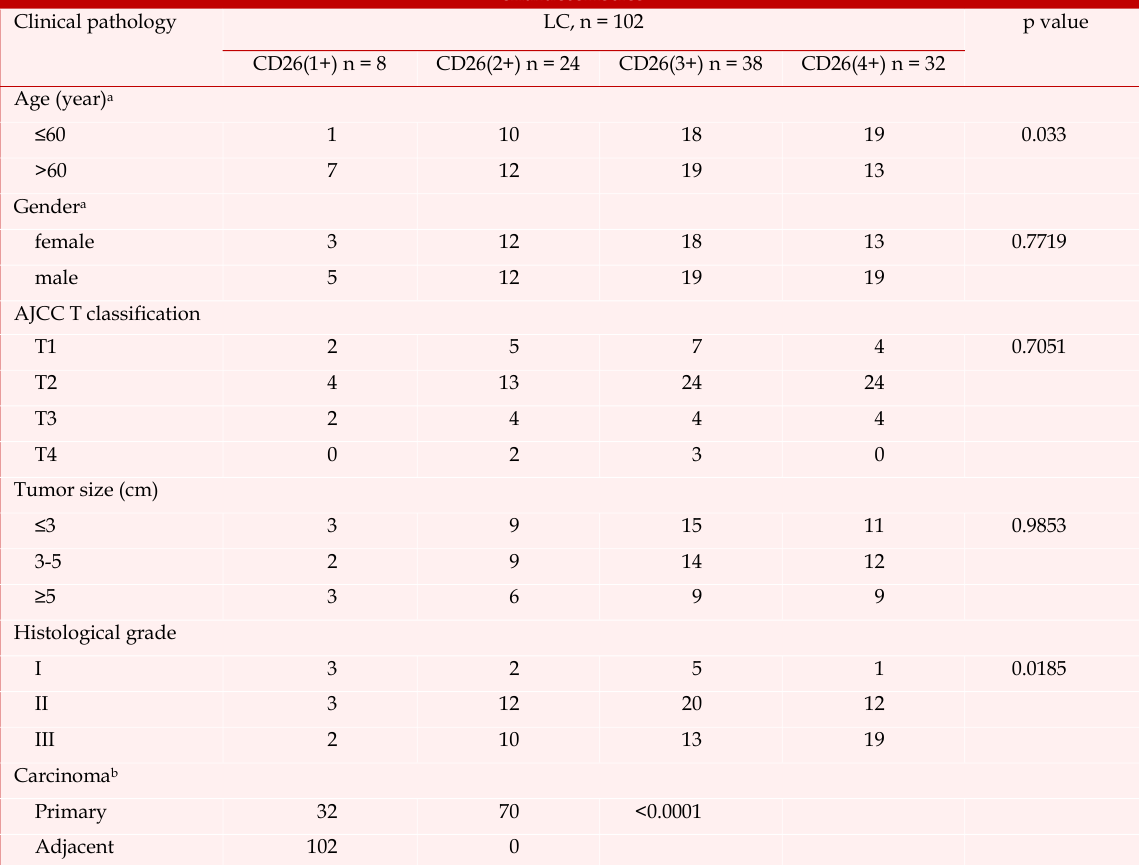
Correlation between CD26 expression in lung adenocarcinoma patients and their clinicopathologic